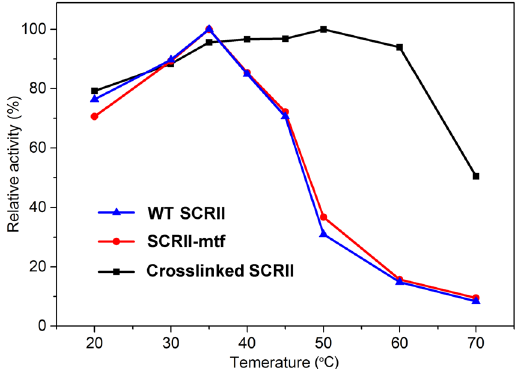
Figure 4. Effects of temperature on enzyme activity for WT SCRII, SCRII-mtf and crosslinked SCRII. Enzyme assay was performed in 100 mM potassium phosphate buffer (pH 6.0), 0.5 mM NADPH, 5 mM substrate, and appropriate enzymes (mg/mL) at 20–70 °C. The relative activity was described as percentage of maximum activity under experimental conditions. All experiments were repeated three